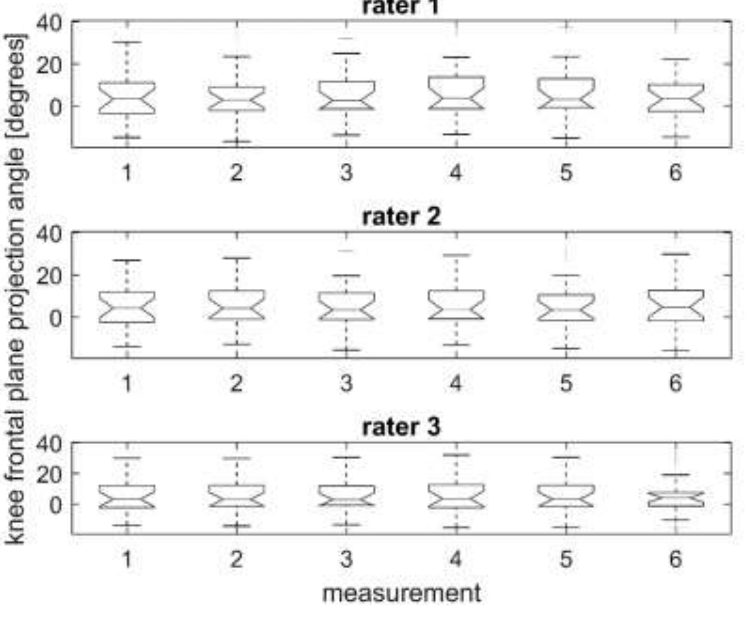
Note . Measurements 1 to 3 ─ day 1; measurements 4 to 6 ─ day 2